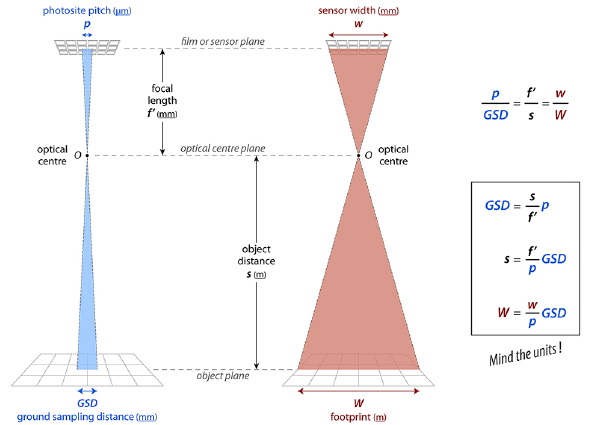
Figure 3 . Deriving the purely geometry-based equation that is fundamental to all kinds of optical imaging.